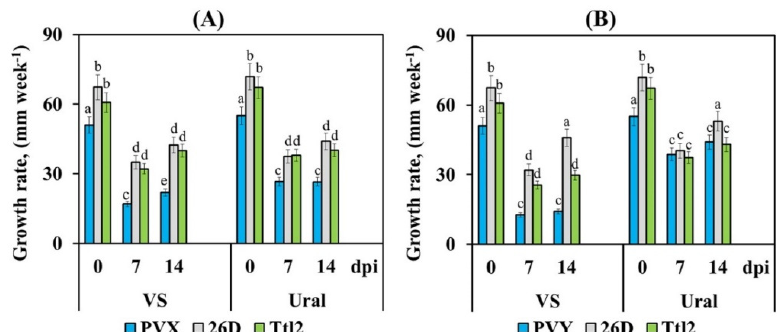
Figure 3. Influence of endophytic strains B. subtilis 26D and B. subtilis Ttl2 on the growth rate in tomato plants of varieties Volovye Serdtse (VS) and Ural infected with PVX ( A ) and PVY ( B ). The samples are indicated as follows: 0 dpi, control non-infected plants; PVX, plants infected with potato virus X; PVY, plants infected with potato virus Y; 26D, plants treated with B. subtilis 26D; Ttl2, plants treated with B. subtilis Ttl2. The figures present means ± SE (n = 6). The treatments marked with different Latin letters in one cultivar are statistically different from the control ones (0 dpi, not infected with viruses and not treated with bacteria) in each time-point, according to the LSD test ( p ≤ 0.05). Treatment with endophytic bacteria increased the growth rate of the uninfected plants of both varieties (Figure S3, see Supplementary Materials). Treatment with strains 26D and Ttl2 reduced the effects of viruses and increased the growth rate in the plants infected with PVX and PVY. The growth rate of the V С plants was restored by 30–40% in the treatments 26D + PVX and Ttl2 + PVX and was recovered by only 20–32% in the Ttl2 + PVY treatment in comparison with the infected non-bacterized plants after 1–2 weeks of infection (Figure 3). The growth rate of the Ural plants was restored by 20–32% in the treatments 26D + PVX and Ttl2 + PVX after 1–2 weeks of infection in comparison with the infected non- bacterized plants (Figure 3). The growth rate decreased by just 10–30% in all the treat- ments of PVY, 26D + PVY and Ttl2 + PVY compared with the uninfected control plants (Figure 3). The growth rate was restored to control values in both varieties in the 26D + PVY treatment at 2 weeks post-inoculation (Figure 3). The growth rate of the plants con- taining endophytes was restored to control values in both varieties in all treatments in 3– 4 weeks after infection with PVX and PVY except for the VS plants with the Ttl2 + PVY treatment (Figure S3). A reduction of the growth rate of the infected tomato plants of both varieties under investigation led to a decrease in plant height and less accumulation of fresh and dry bio- mass (Table 2, Figure S3). PVX and PVY had a much stronger effect on these indicators in the plants of cv. VS (Table 2). Treatment with 26D and Ttl2 restored plant height and bio- mass accumulation in the PVX- and PVY-infected plants of both varieties to the level of the uninfected control plants in all treatments except for the Ttl2 + PVY treatment in VS (Table 2, Figure S3).